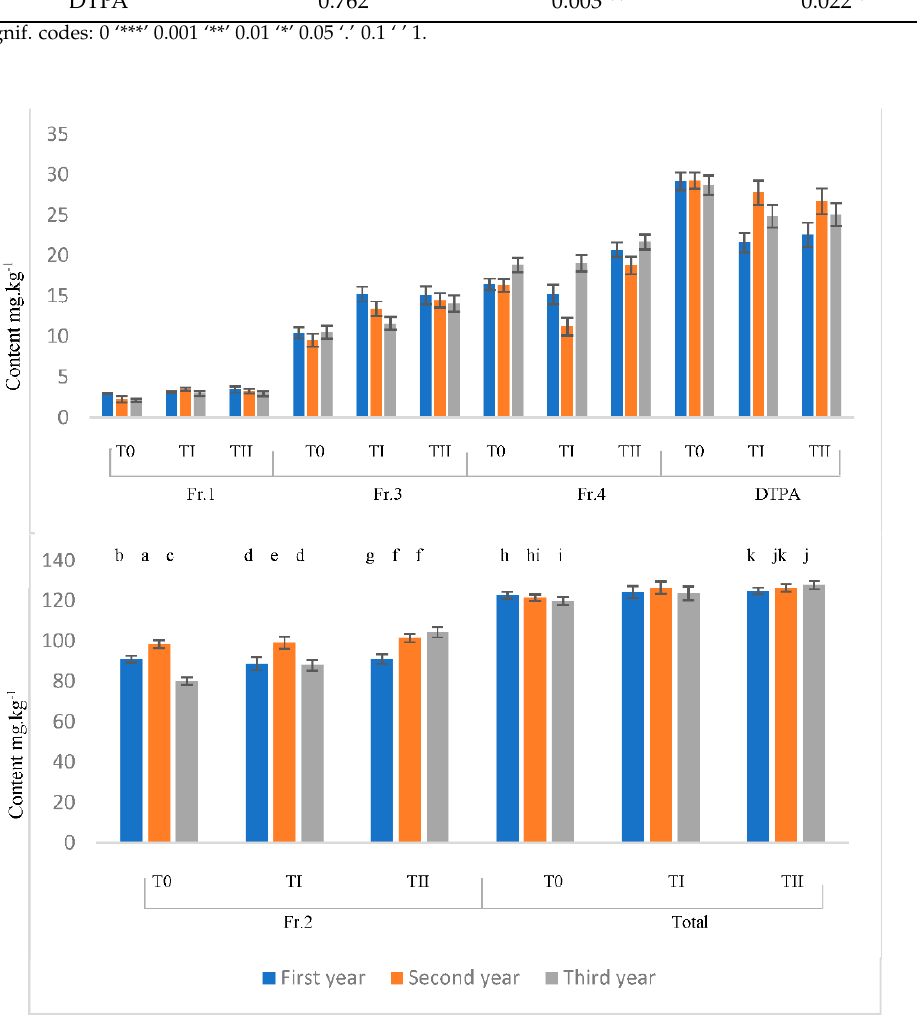
Figure 1. The effect of treating the soil with two amendments on mean Pb amounts in fractions Fr. 1-4, Total and Pb DTPA in soil samples: T0—control soil, TI—soil with compost addition and TII—soil with FA addition. In the figure, the letters denote homogenous groups and numbers mean SD values.